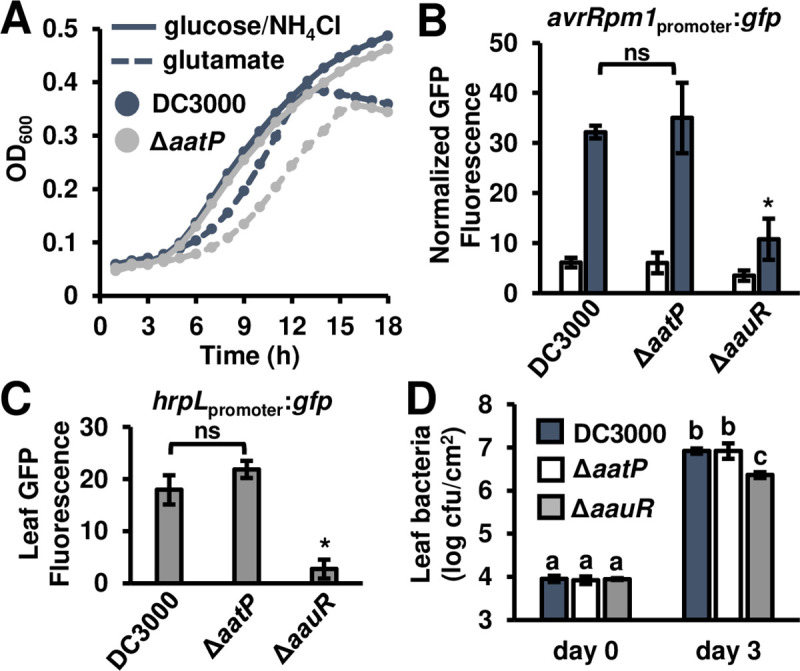
Amino acid transport and T3SS-inducing functions of the aat/aau locus are genetically separable.(A) Growth of DC3000 and ΔaatP strains in M9 minimal medium supplemented with 10 mM glutamate. Graphed are means of optical density at λ = 600 nm (OD600), n = 3. (B) GFP fluorescence from DC3000, ΔaatP, and ΔaauR avrRpm1promoter:gfp reporter strains cultured in minimal medium (MM) with 10 mM fructose (open bars) or 10 mM fructose and 200 μM glutamate (filled bars) for 6 hours. Graphed are means ± SE of GFP fluorescence normalized to OD600 and background fluorescence from empty vector strains; n = 4. Asterisk denotes significant difference based on t-test comparison with DC3000, P < 0.01; abbreviation ns is not significant, α = 0.05. (C) GFP fluorescence of Arabidopsis leaf tissue syringe-infiltrated with 1 x 108 cfu/mL of DC3000, ΔaatP or ΔaauR strains each carrying a hrpLpromoter:gfp reporter plasmid. Graphed are means ± SE of GFP fluorescence from infected tissue 6 hours post-infection, n = 4. Asterisk denotes significant difference based on t-test comparison with DC3000, P < 0.01; abbreviation ns is not significant, α = 0.05. (D) 1 x 106 cfu/mL of DC3000, ΔaatP or ΔaauR strains were syringe-infiltrated into Arabidopsis leaves. Leaf bacteria populations were enumerated on day 0 and day 3 by serial dilution plating of leaf extracts. Graphed are log-transformed means ± SE of bacteria from infected plants, n = 3 for day 0 and n = 4 for day 3. Small-case letters denote significance groupings based on pairwise t-tests, P < 0.05. Results in all panels are representative of 3 independent experiments.